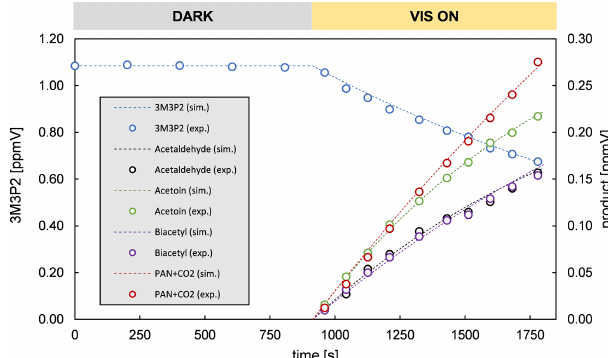
Figure 7. Experimental and simulated time profiles obtained for a 3M3P2 + OH experiment.